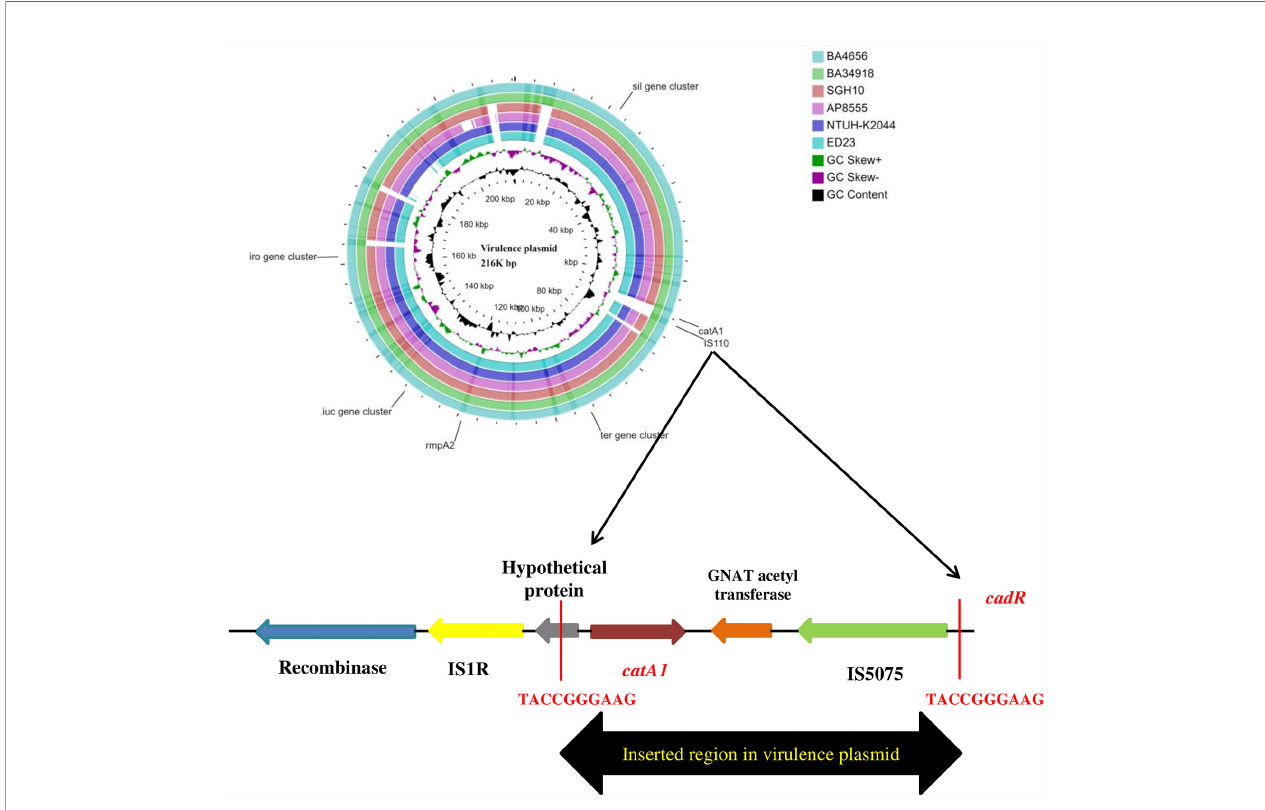
FIGURE 4 | Comparison of virulence plasmid of hypervirulent (hv) Klebsiella pneumoniae isolates BA4656 and BA34918 with virulence plasmids from K. pneumoniae strains SGH10, NTUH-K2044, AP8555, and ED23. The plasmid carried virulence genes including rmpA/rmpA2 , iro , and iuc gene clusters along with heavy metal resistance encoding ter, sil , and pco gene clusters. catA1 , coding for chloramphenicol resistance with IS5075 (IS110 family) was inserted in plasmids of BA4656 and BA34918. Inserted region of 2,744 bp in the virulence plasmid carrying catA1 is shown below. Inserted region is fl anked by a repeat region of 10bp (TACCGGGAAG) which could possibly be a hotspot for integration.